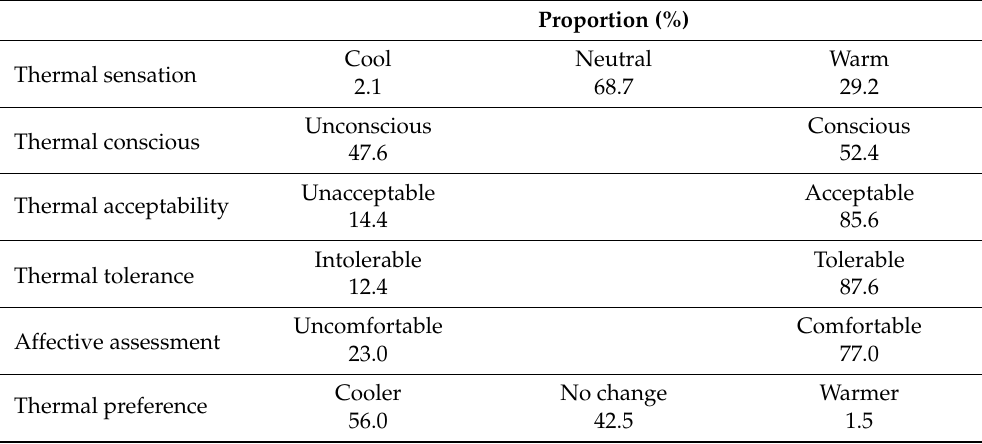
Table 6. Statistical summary of subjective votes.